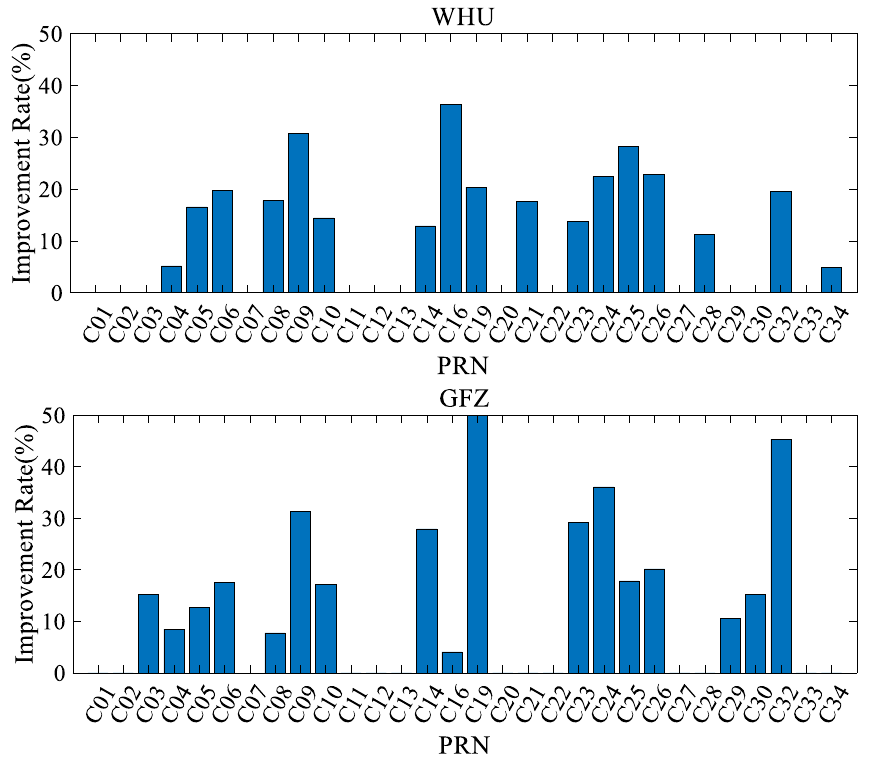
Figure 9. Improvement of the TFAM relative to the SAM.